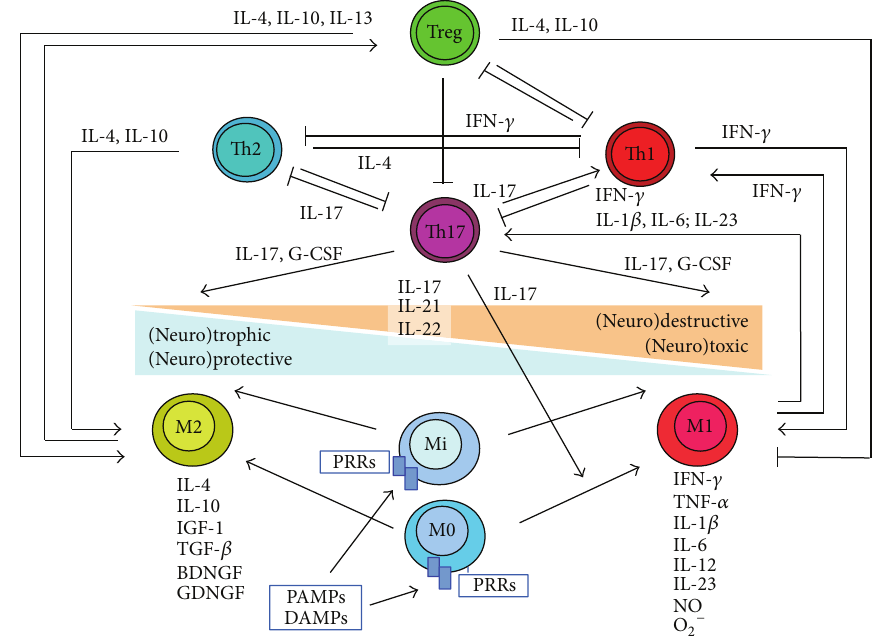
Figure 2: Simplified hypothetical model of immune cell interaction. ↑ = activation, induction; T = inhibition, reduction; BDNF = brain derived neurotrophic factor; DAMP = danger associated molecular pattern; G-CSF = granulocyte-colony stimutating factor; GDGF = glial- cell-derived neurotrophic factor; IGF-1 = insulin-like growth factor; IL = interleukin; Mi = microglia; M0 = nonactivated macrophages; M1 = classically activated macrophages; M2 = alternatively activated macrophages; PAMP = pathogen associated molecular pattern; PRRs = PAMP recognition receptors; and TGF- 𝛽 = transforming growth factor- 𝛽